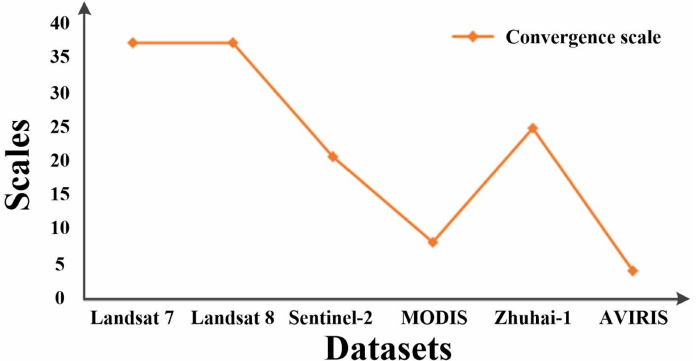
Figure 13. The best encoding scales of different datasets in this research.